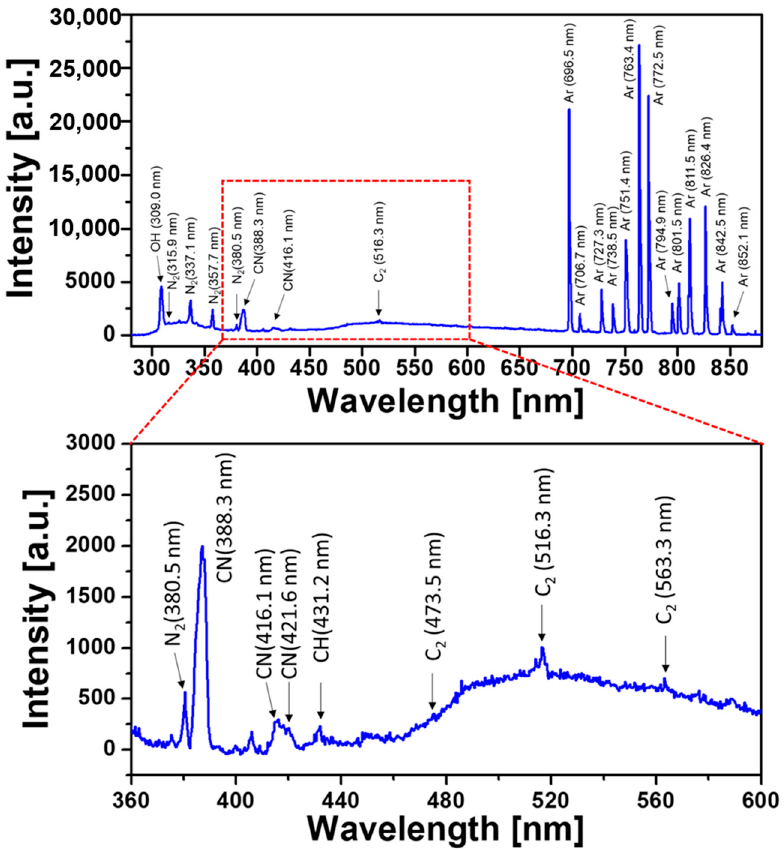
Figure 3. Optical emission spectra (OES) measured during polymerization reaction.